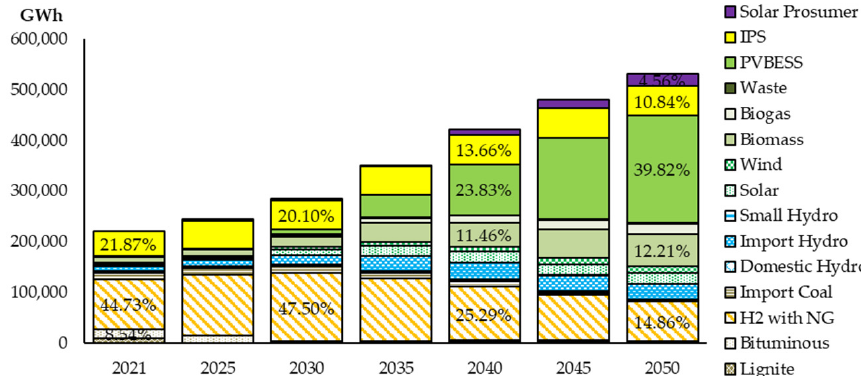
Figure 16. Fuel mix ratio of the 25% hydrogen scenario.